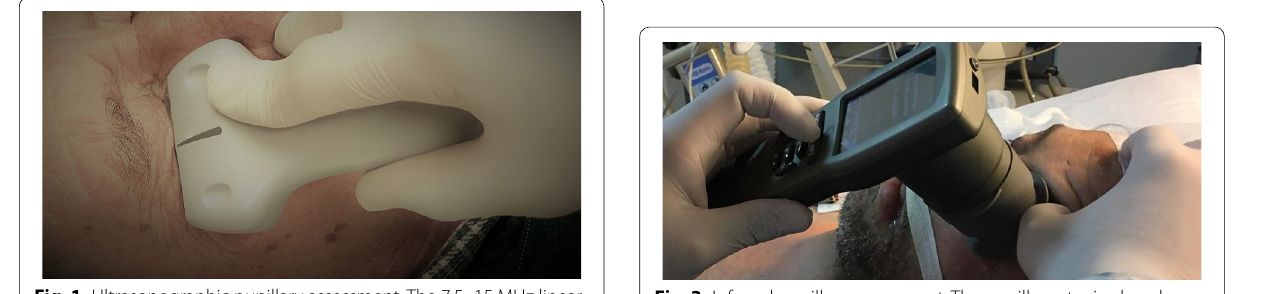
Fig. 3 Infrared pupillary assessment. The pupillometer is placed over the open eye, which shows a light stimulus to assess for the pupillary light